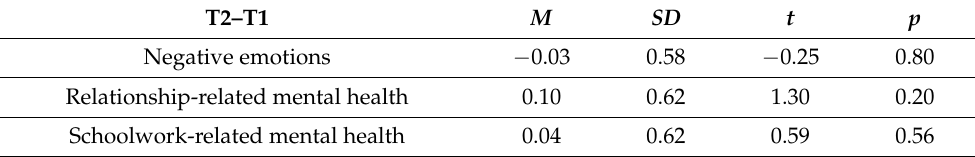
Table 8. Differences between key variables in the control group at T1 and